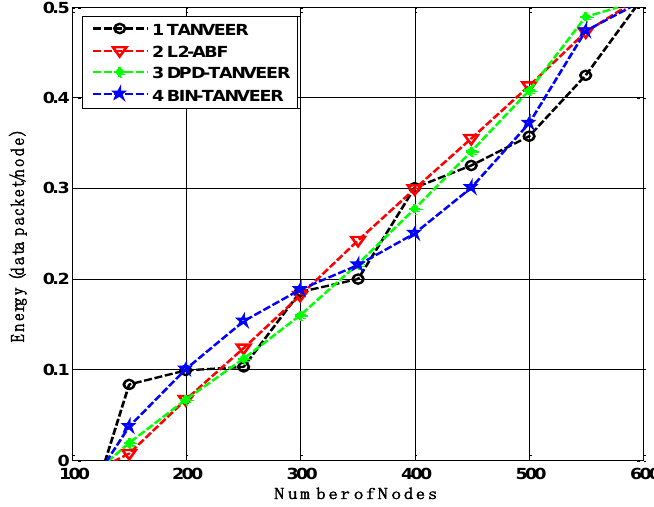
Figure 13. Packet delivery analysis of TANVEER vs. L2-ABF.